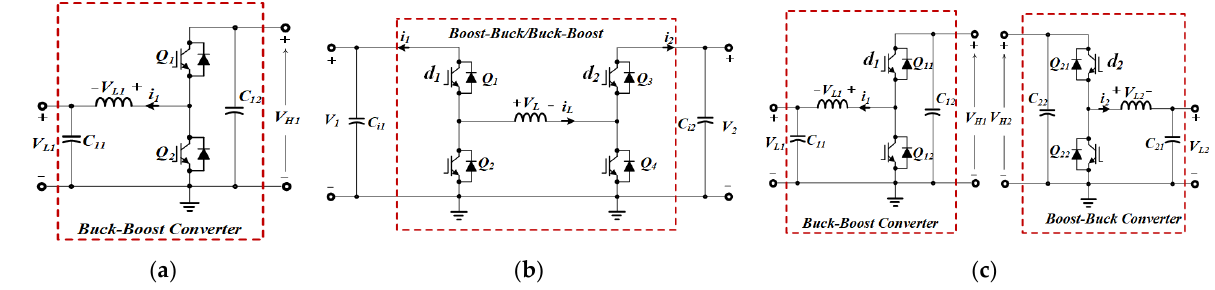
Figure 1. Bidirectional boost-buck converter topology. ( a ) Buck-Boost Converter, ( b ) Boost- Buck/Buck-Boost Converter, ( c ) Buck-Boost/Boost-Buck Converter. Buck/Buck-Boost Converter, ( c ) Buck-Boost/Boost-Buck